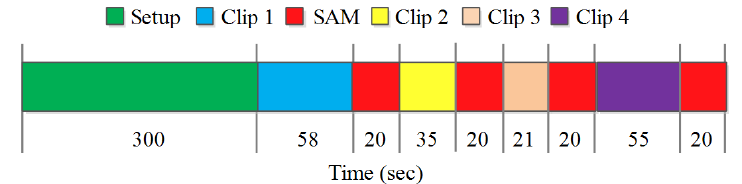
Figure 4. Experimental procedure followed for physiological data acquisition in response to TEM